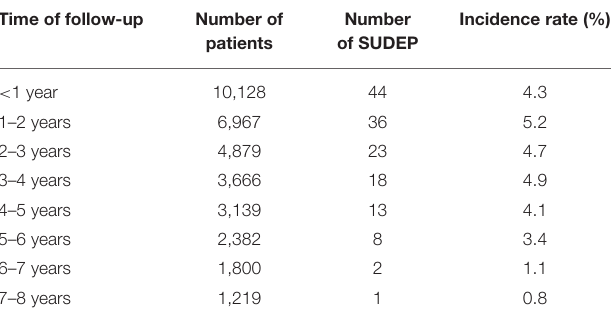
TABLE 3 | Trend of SUDEP incidence rate with the time of follow-up. Time of follow-up Number of